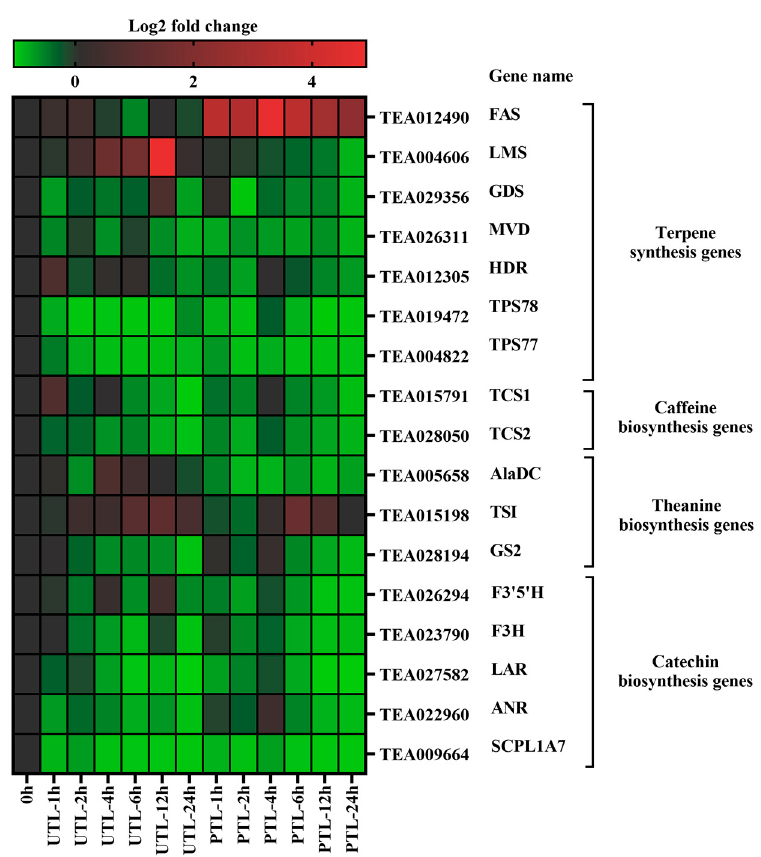
Figure 4. Heatmap for expression levels of biosynthetic genes in UTL and PTL relative to FTL. Red represents upregulation; green represents downregulation. FAS , farnesene synthase; LMS , limonene synthase; GDS , germacrene D synthase; MVD , mevalonate-5-pyrophosphate decarboxylase; HDR , 4-hydroxy-3-methylbutenlyl diphosphate reductase; TPS78 , terpene synthase 78; TPS77 , terpene synthase 77; TCS1 , tea caffeine synthase 1; TCS2 , tea caffeine synthase 2; AlaDC , alanine decarboxylase; TSI , theanine synthetase; GS2 , glutamine synthetase 2; F3’5’H , flavonoid 3’,5’-hydroxylase; F3H , flavonoid 3-hydroxylase; LAR , leucoanthocyanidin reductase; ANR , anthocyanidin reductase; SCPL1A7 , serine carboxypeptidase-like acyltransferase 7.